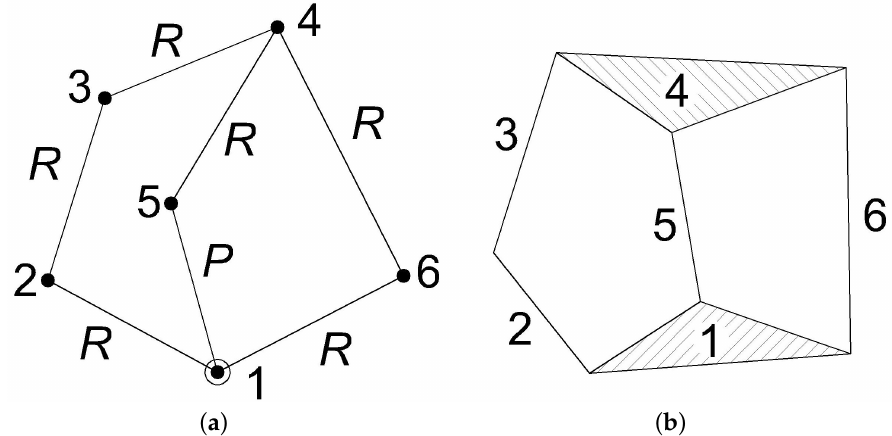
Figure 5. A representation of the Stephenson’s graph ( a ) and kinematic chain ( b